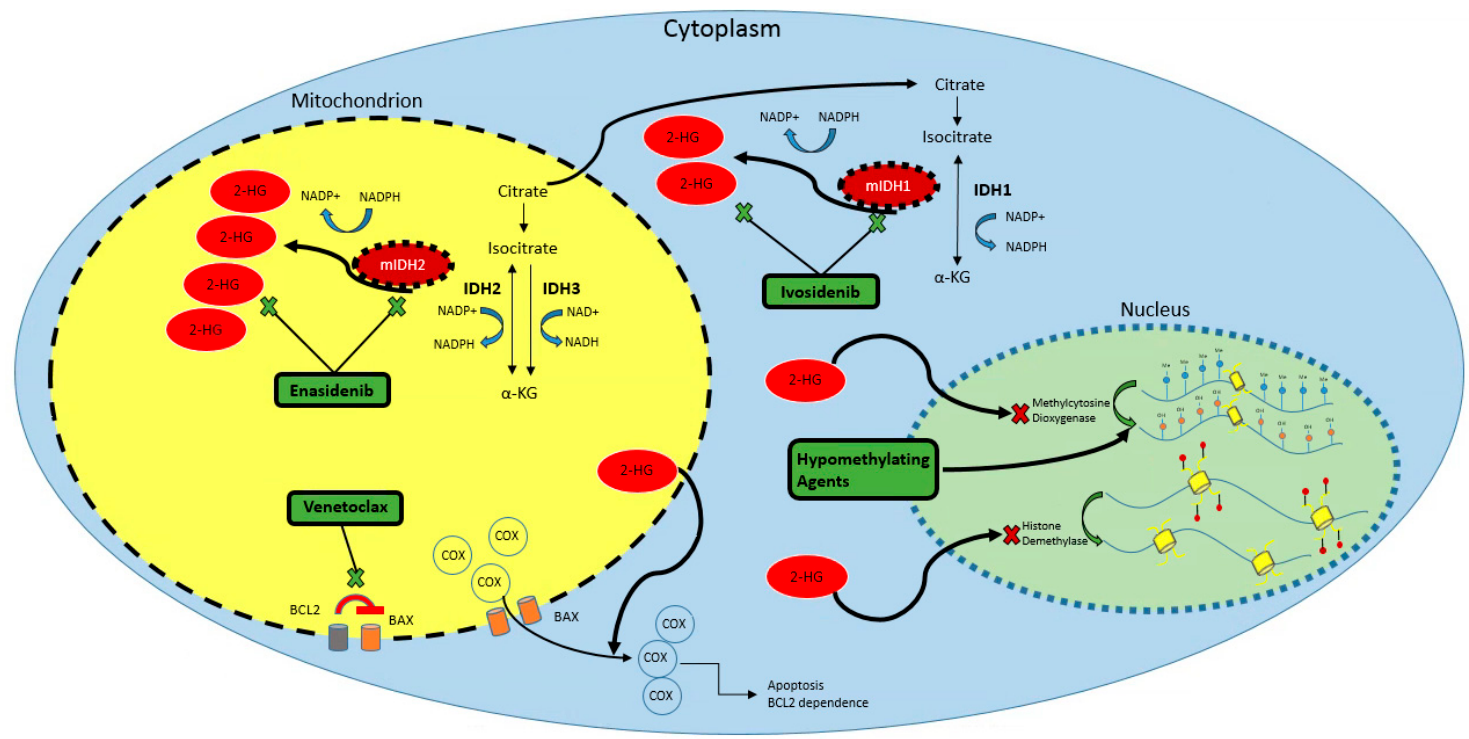
Figure 1. IDH pathway and targets in acute leukemia. IDH1/2 catalyze the conversion of isocitrate to α -KG. However, mutations in the catalytic active site of IDH1/2 causes increased affinity to NADPH and α -KG, leading to accumulation of the oncometabolite 2-HG. 2-HG accumulation has several detrimental effects at the cellular level, including hypermethylation of DNA, silencing in cell differentiation pathways (HOX, MAPK, WNT, TGF β ), and impaired metabolic regulation resulting in apoptosis and BCL2 dependence. Specific inhibitors including enasidenib and ivosidenib bind to mIDH1/2 with a greater affinity than isocitrate allowing normal cellular process to continue and decrease the amount of 2-HG production. Other promising agents work on the downstream effects of 2-HG accumulation, including hypomethylating agents (azacitidine and decitabine) restoring cellular differentiation, as well as venetoclax restoring metabolic regulation and apoptotic pathways. Abbreviations: IDH1 = isocitrate dehydrogenase 1, IDH2 = isocitrate dehydrogenase 2, IDH3 = isocitrate dehydrogenase 3, mIDH1 = mutated IDH1, mIDH2 = mutated IDH2, 2-HG = beta-hydroxyglutarate, α -KG = alpha-ketoglutarate, COX = cytochrome c oxidase, Me = methyl group, OH = hydroxyl group, BCL2 = B-cell lymphoma 2, BAX = BCL2 associated protein X, NADP/H = nicotinamide adenine dinucleotide phosphate, NAD/H = nicotinamide adenine dinucleotide.